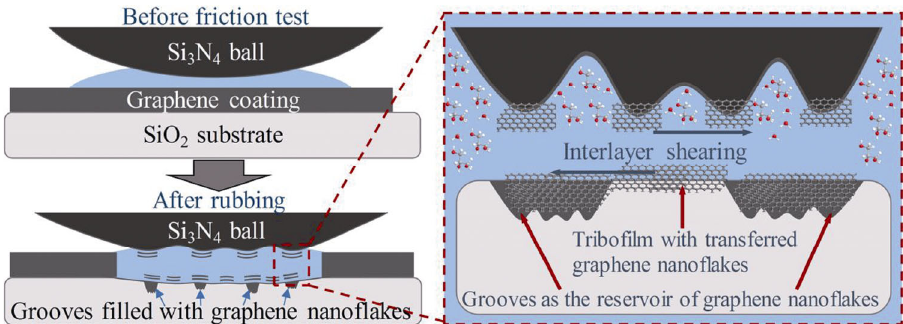
Fig. 12 Lubrication model of hydrophobic pristine graphene nanoflakes and the glycerol aqueous solution. Reproduced with permission from Ref. [92], © American Chemical Society